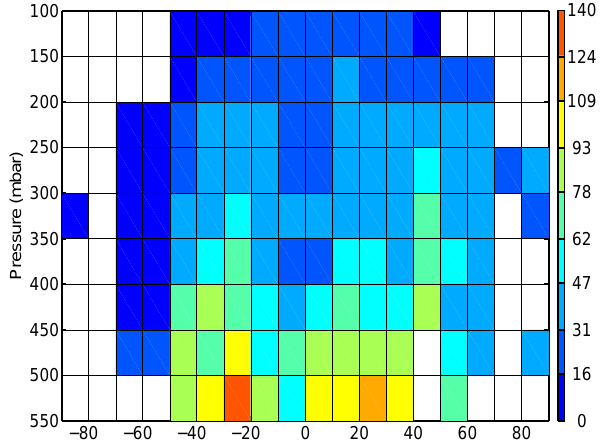
Fig. 6. Measured distribution of FA (pptv) by ACE-FTS from 2004 to 2008. Median of FA measurements is calculated in 10 ◦ lati- tude 50mbar bins. Only cells with more than ten measurements are shown.